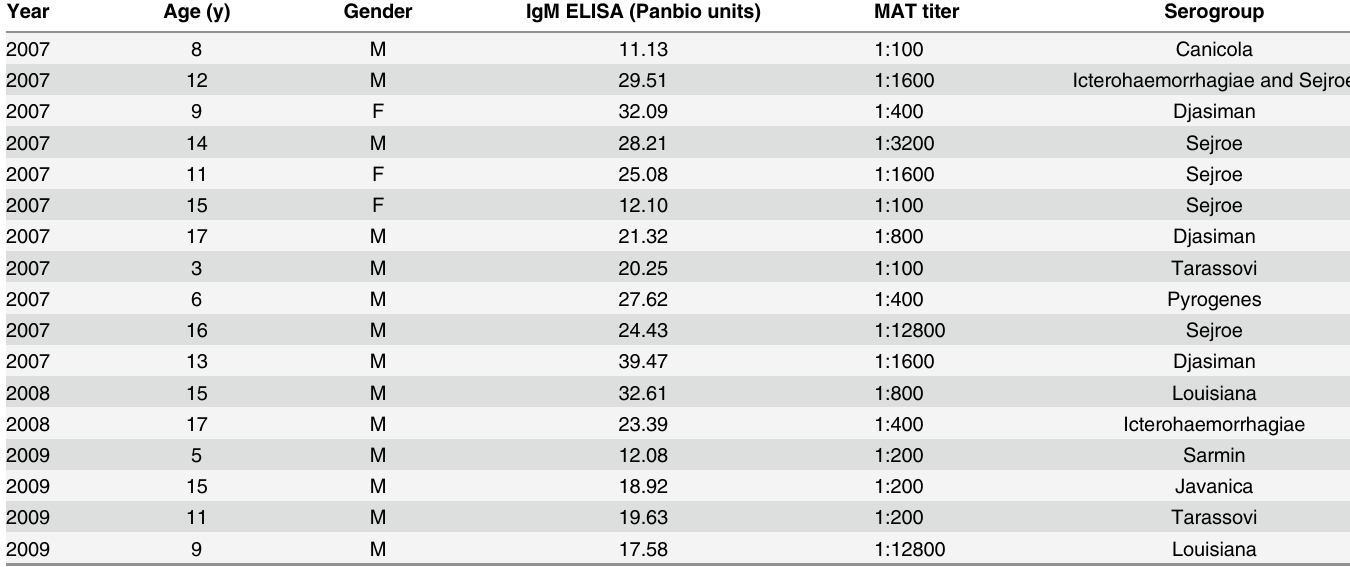
Table 2. Leptospira microscopic agglutination (MAT) titres obtained in 17 positive convalescent samples, febrile episodes, 2007 – 2009 rainy sea- sons, Kampong Cham province, Cambodia.